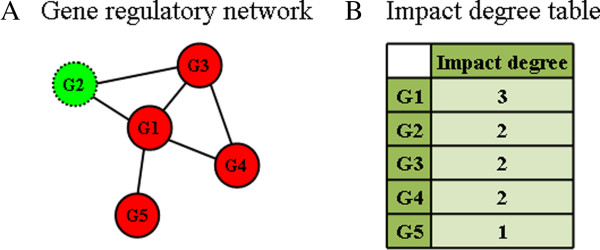
Generation of an impact degree table.